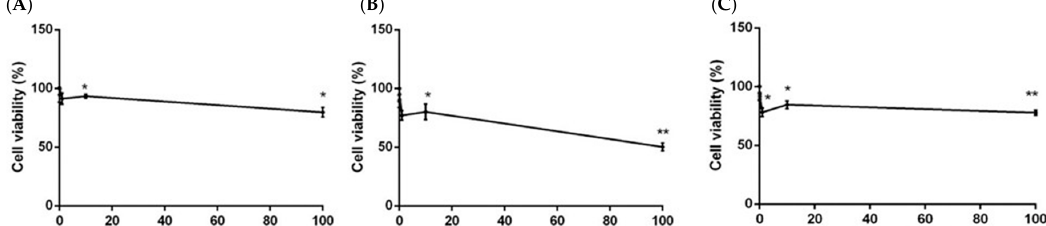
Figure 2. Cell viability calculated as percentage after MTT assay. Cells were treated with different concentrations (0.01–100 µg/mL) of petroleum ether ( A ), chloroform ( B ), and methanol ( C ) extracts of P. aculeata , for 24 h and solvent (DMSO, 0.1%) alone. Data are the mean ± SD of three experiments * p < 0.05, ** p < 0.01, vs. DMSO.